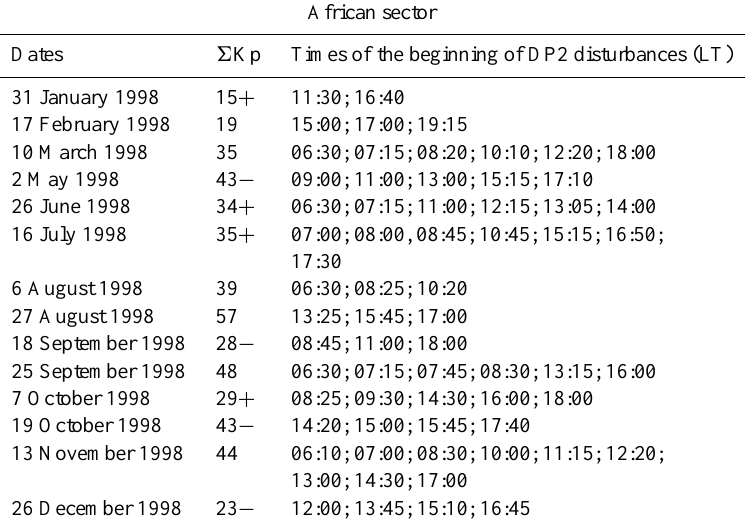
Table 3a. Magnetic storms days selected of 1998 and times of the beginning of DP2 disturbances at Addis Ababa (AAE) over African